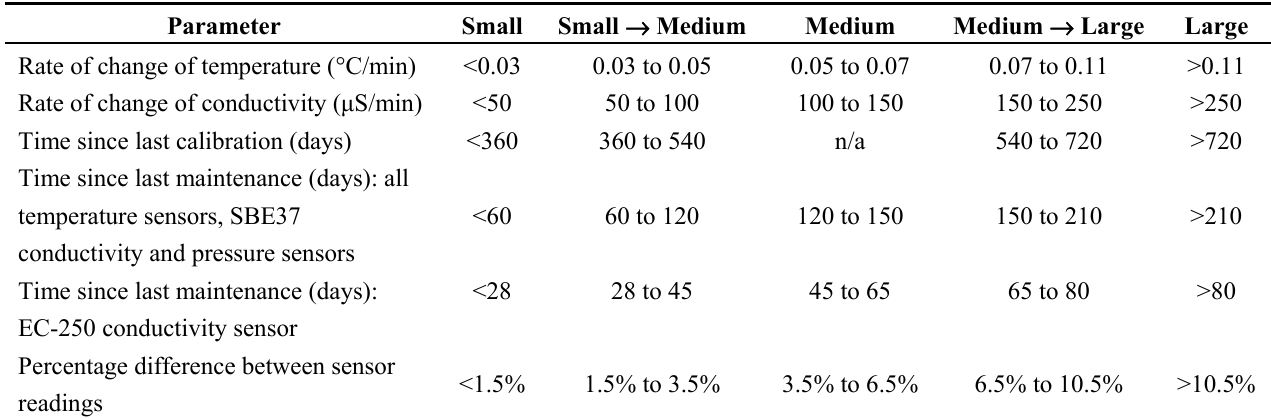
Table 1. Membership functions for the parameters contributing to data